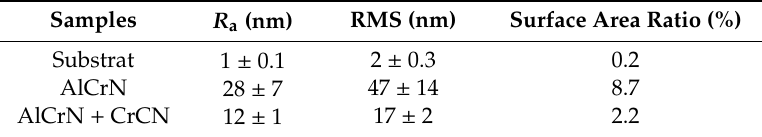
Table 2. Characteristics of samples’ topography (AFM).